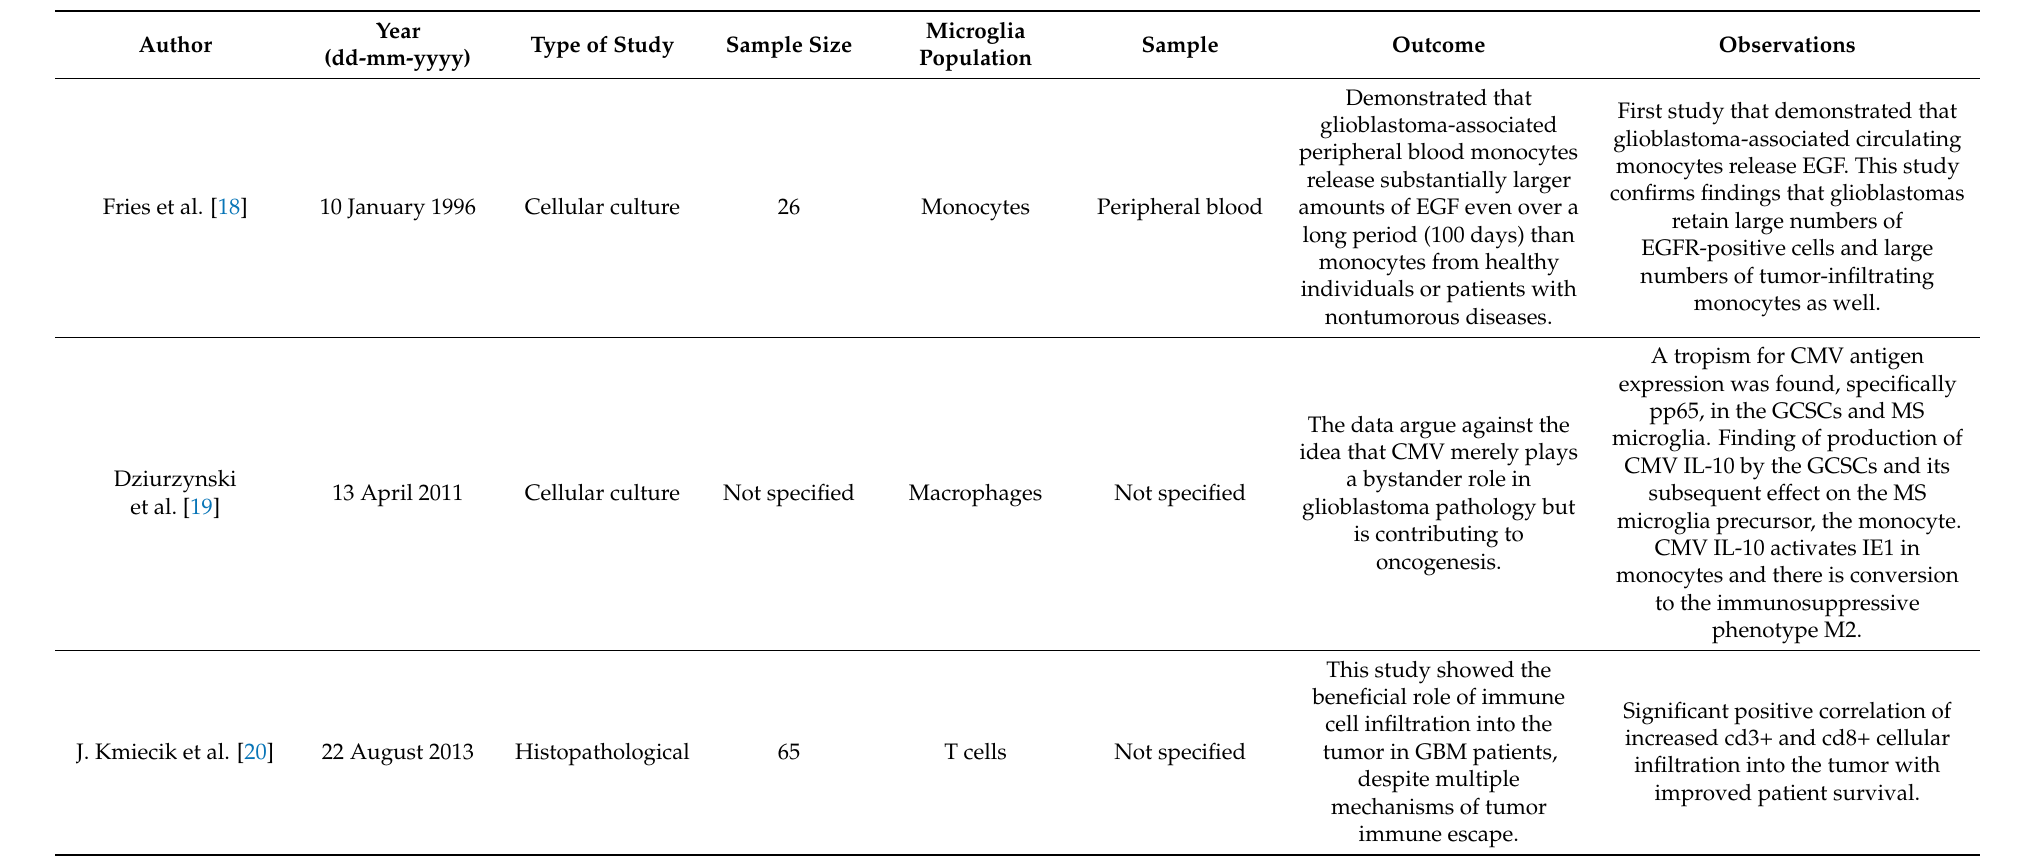
Table 2. Microglia crosstalk with dedifferentiated and stem-like